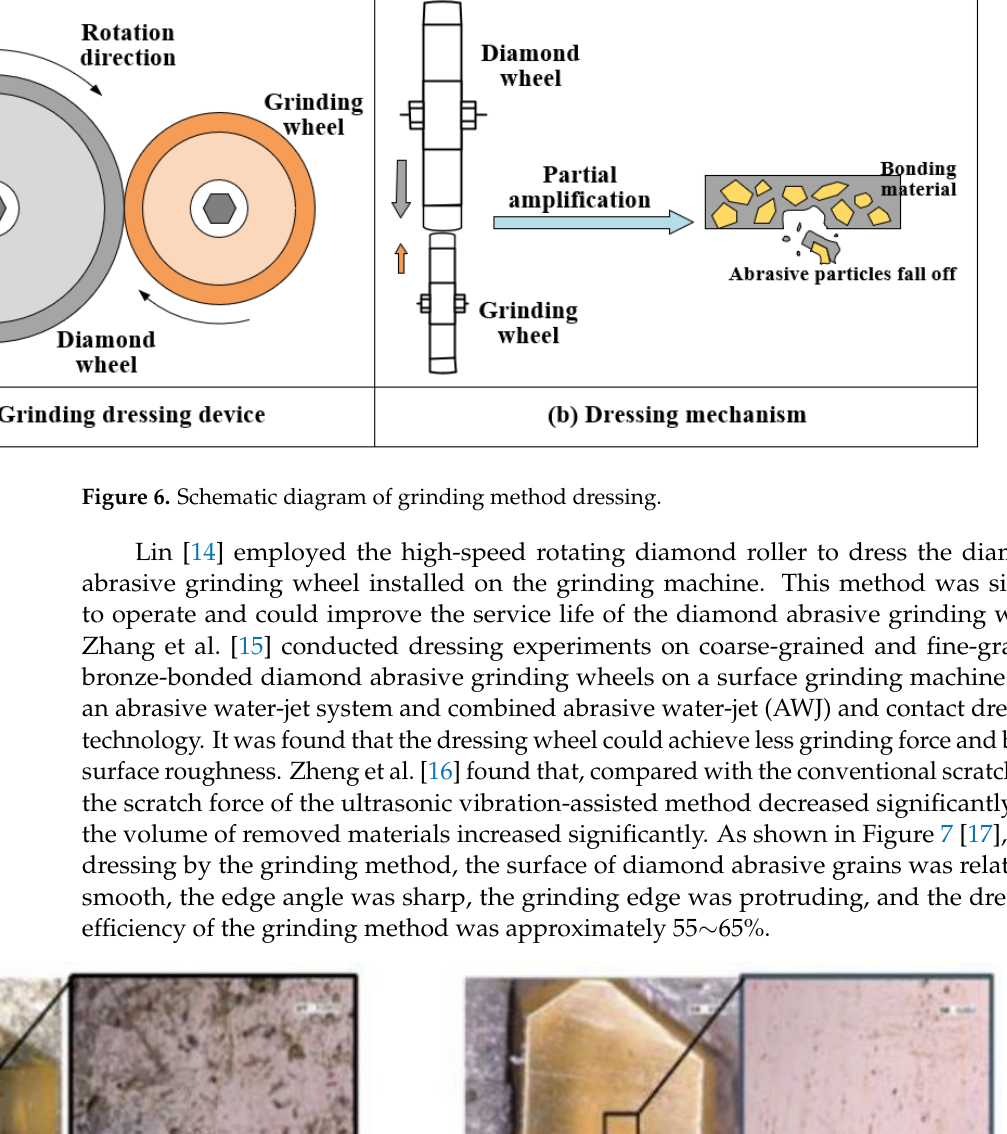
Figure 6. Schematic diagram of grinding method dressing.